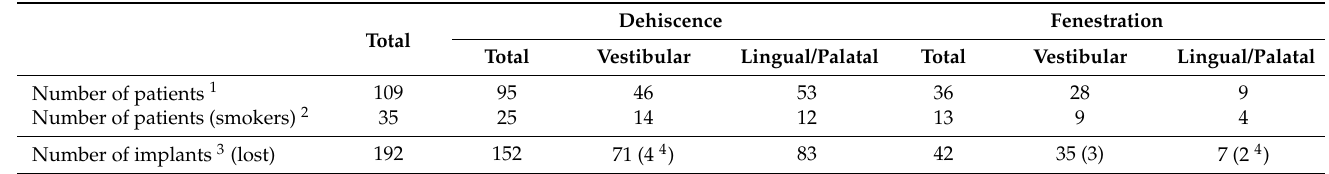
Table 2. Distribution of patients and implants according to the implant’s defect localization.